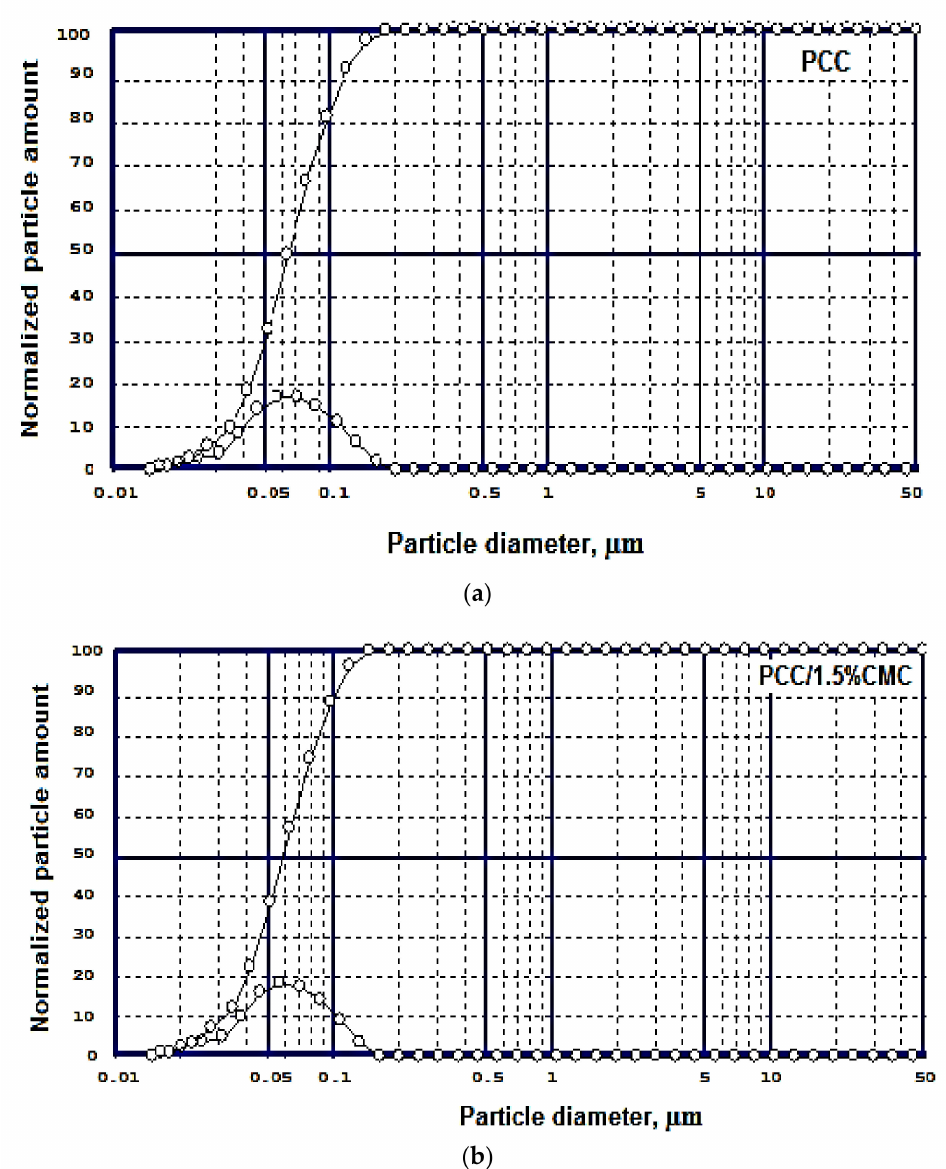
Figure 5. Particle size distribution of PCC ( a ) and PCC/1.5% CMC ( b ) (particle diameters and cumulative